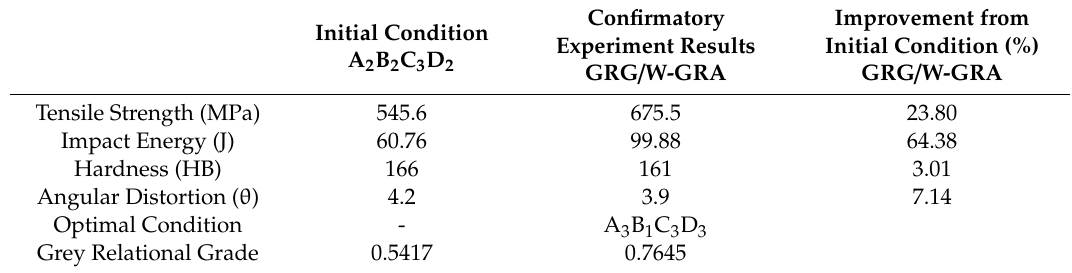
Table 10. Comparison Summary of confirmatory